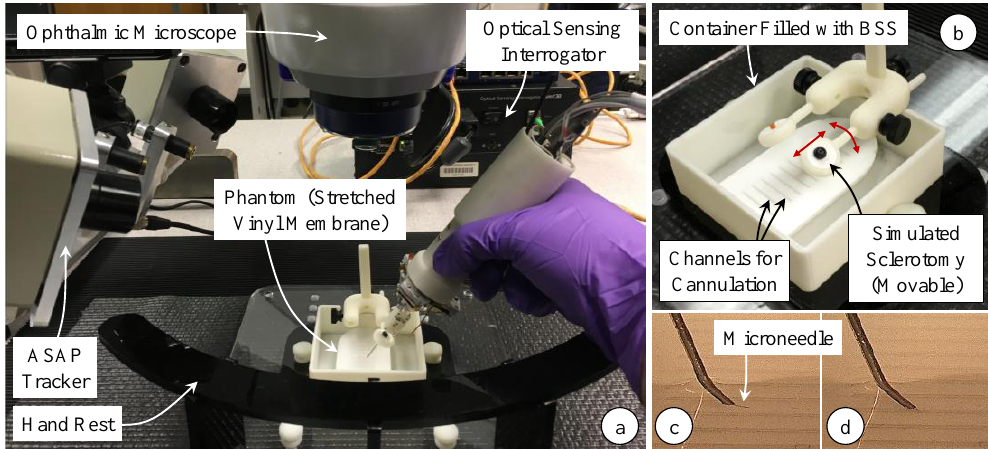
Figure 8. Experimental setup for cannulation experiments using an artificial phantom. ( a ) Stretched vinyl membranes simulating the vein walls were punctured using the force-sensing micro-needle under an ophthalmic microscope; ( b ) An acrylic insert with channels (1 mm wide) was used to tension the vinyl layer. The phantom was placed inside a container filled with balanced salt solution (BSS). To approach the channels on the phantom, the needle was inserted through the trocar on the movable (as shown with red arrows) sclerotomy port. A digital microscope was used to monitor the operational area from the side and assess the moment of puncture: ( c ) microneedle above the vinyl layer before puncture; ( d ) microneedle inside the channel after puncturing through the vinyl membrane.